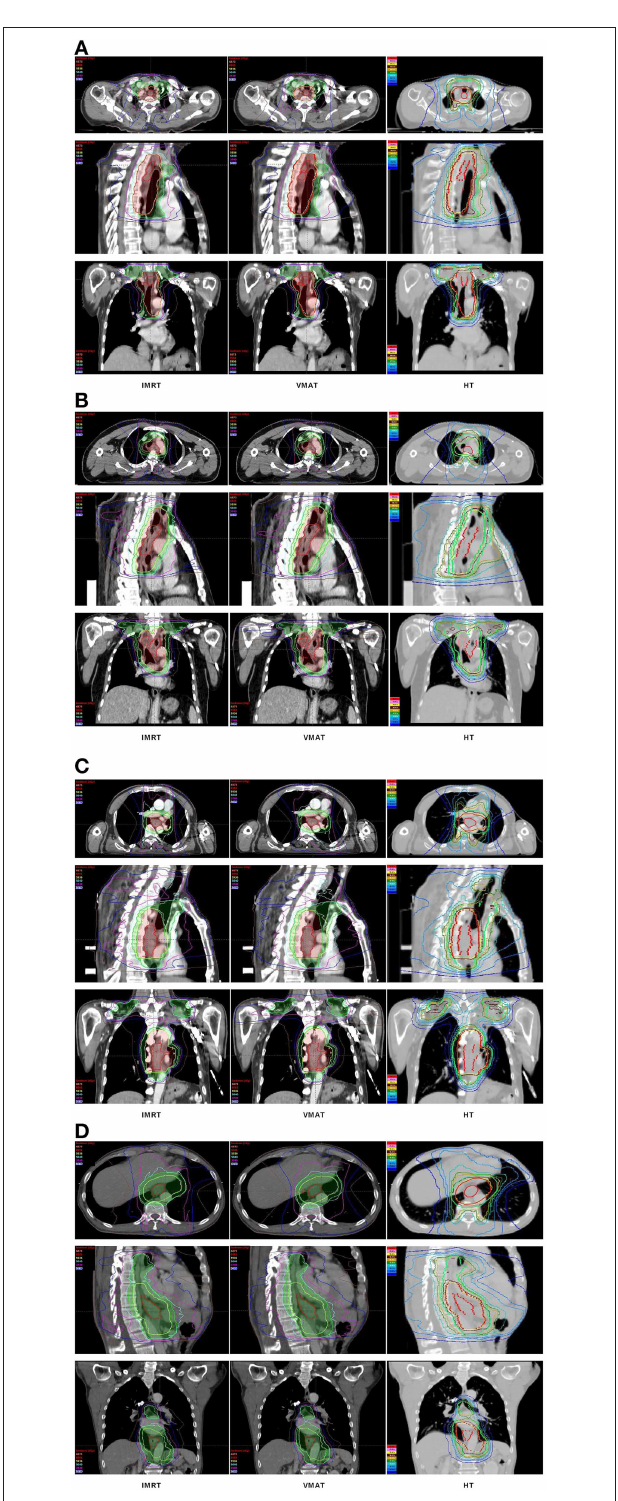
FIGURE 1 | Dose distributions. Dose distributions of IMRT (left), VMAT (middle), HT (right) for a cervical (A) , upper (B) , middle (C) , and lower (D) thoracic EC in axial, sagittal, and coronal views. EC, esophageal cancer; IMRT, intensity modulated radiotherapy; VMAT, volumetric modulated arc radiotherapy; HT, helical